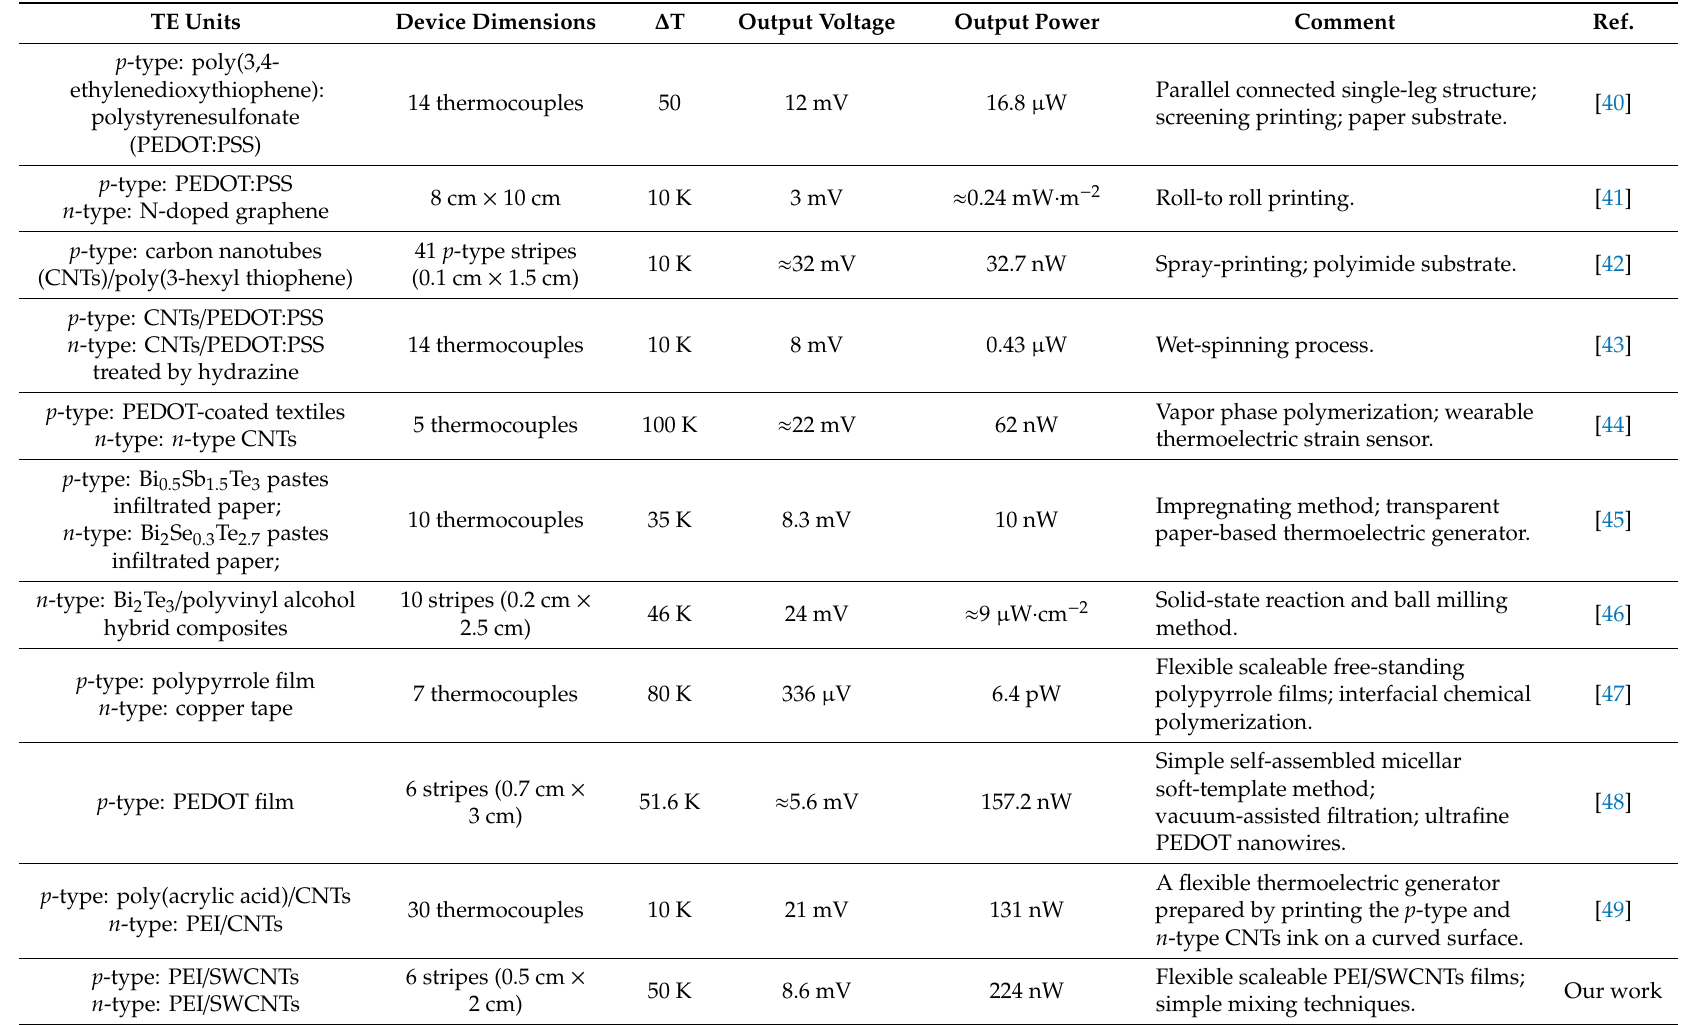
Table 2. A summary of some high-performance flexible thermoelectric